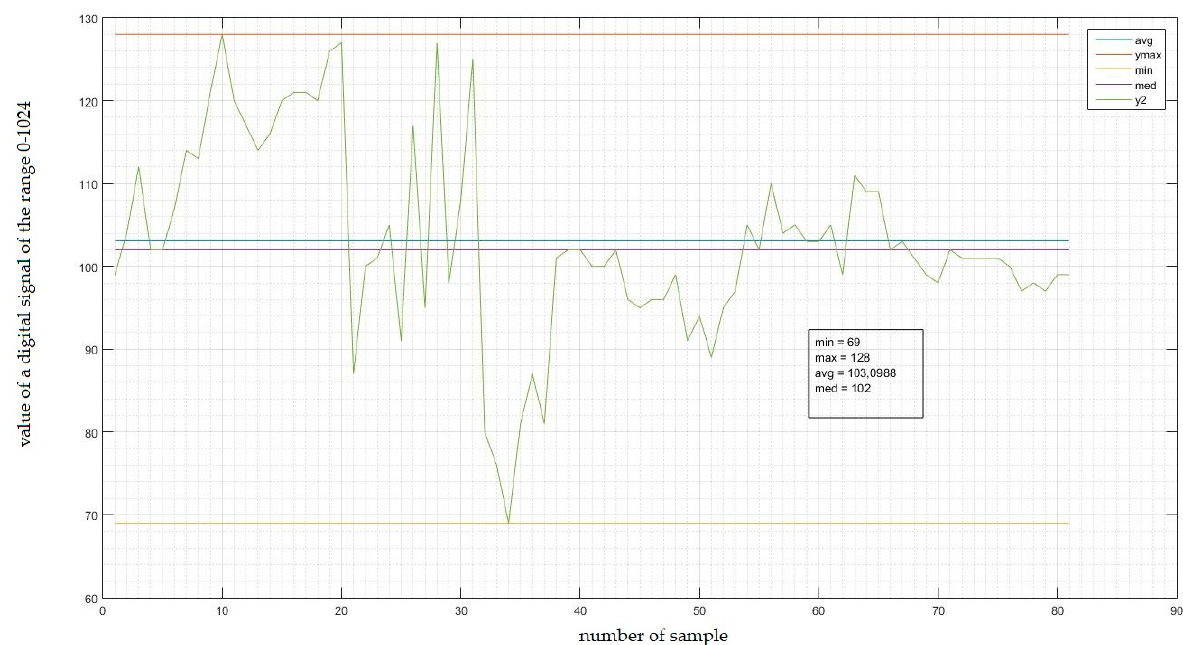
Figure A5. Data from the sensor on a maximally bent middle finger.